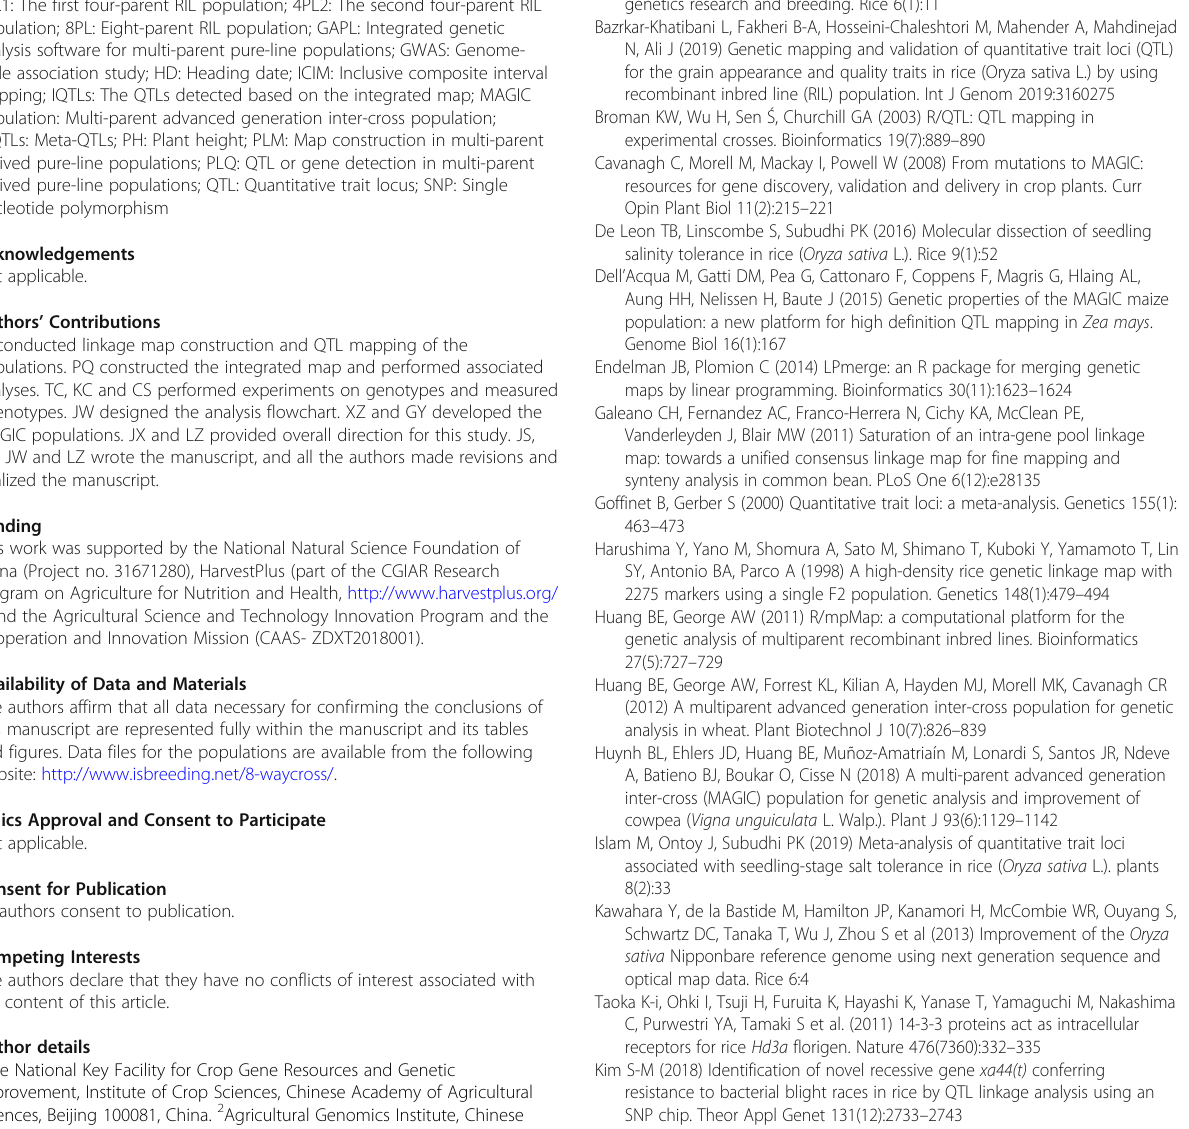
Additional file 3: Table S3. QTLs for heading date and plant height in the 4PL1 population based on the linkage map Additional file 4: Table S4. QTLs for heading date and plant height in the 4PL2 population based on the linkage map Additional file 5: Table S5. QTLs for heading date and plant height in the 4PL1 population based on the integrated map Additional file 6: Table S6. QTLs for heading date and plant height in the 4PL2 population based on the integrated map Additional file 7: Table S7. Physical position of significant SNPs associated with cloned genes detected by GWAS and ICIM Additional file 8: Figure S1. General information on the markers in the three multi-parent populations Additional file 9: Figure S2. Projection of QTLs detected in the three multi-parent populations on the integrated map Additional file 10: Figure S3. LOD scores across the genome from QTL mapping based on the integrated